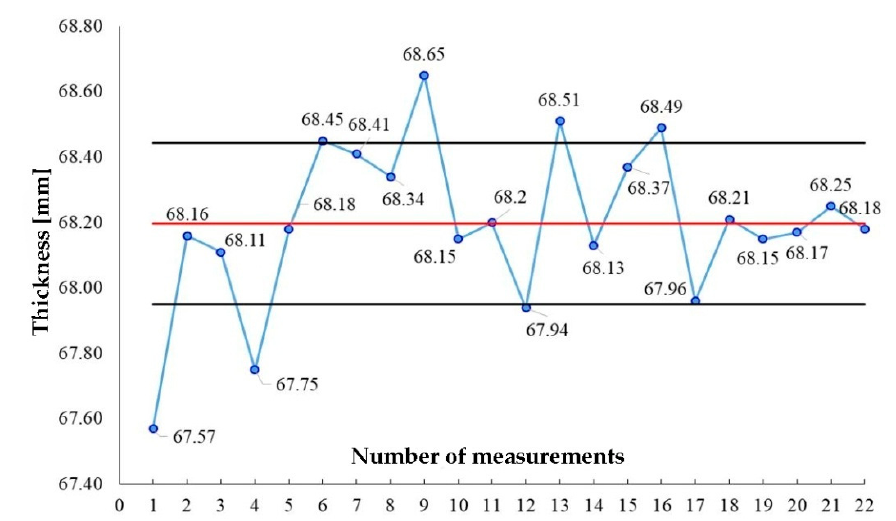
Figure 7. Inner rubber band width variance for CG1000.